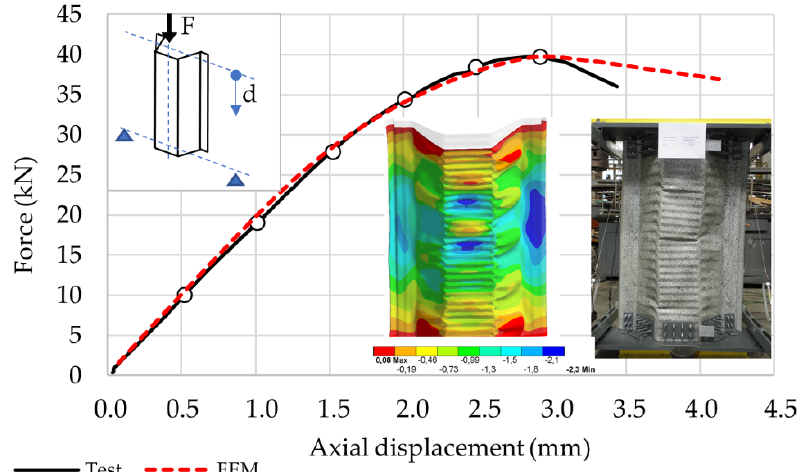
Figure 9. The graphical representation of the FEM versus the experimental test results for the Model 0 sample’s equilibrium path. Table 4. The tabulation of the calculation versus the experimental test results at different eccentrici- ties.